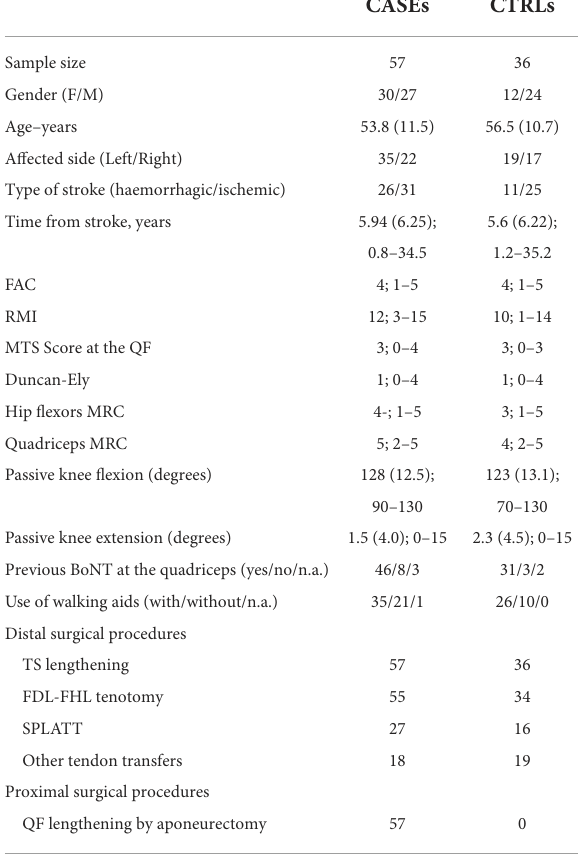
TABLE 1 Sample characteristics for both CASEs and